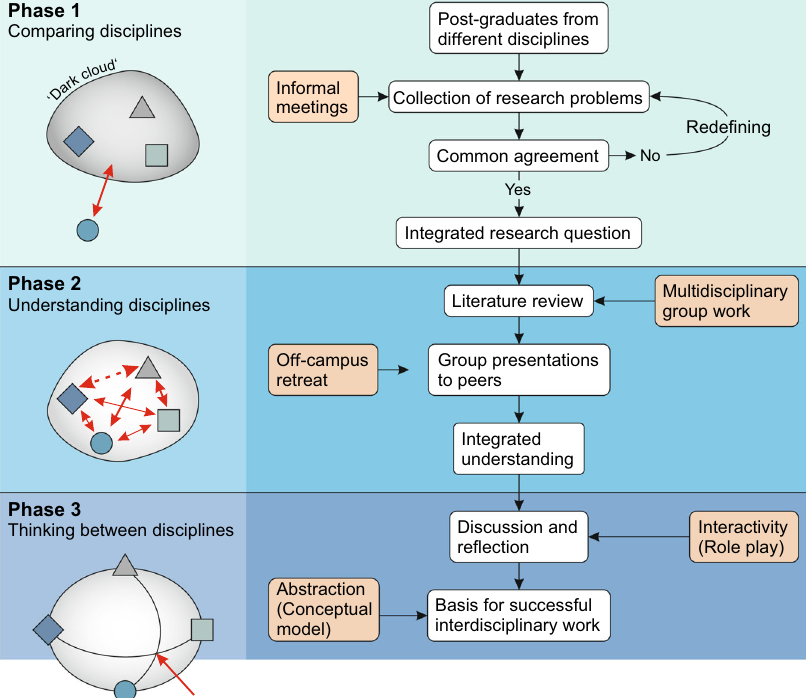
Fig. 3 Practical guideline to approach an interdisciplinary problem. Geometric objects (triangle, square, circle, and diamond) indicate different disciplines. The term ‘ dark cloud ’ refers to an unresolved challenge that has to be encountered